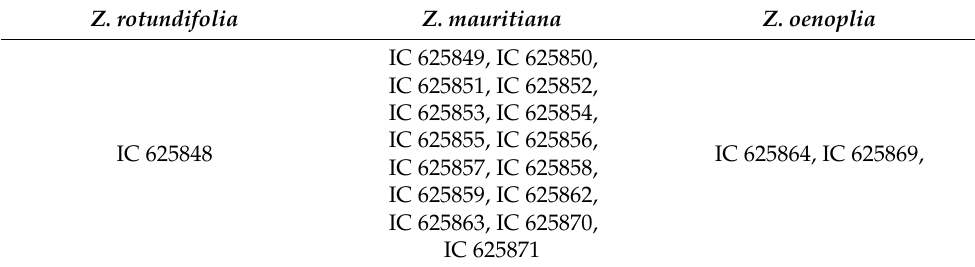
Table 1. Species-wise grouping of 18 accessions of jujube used in the